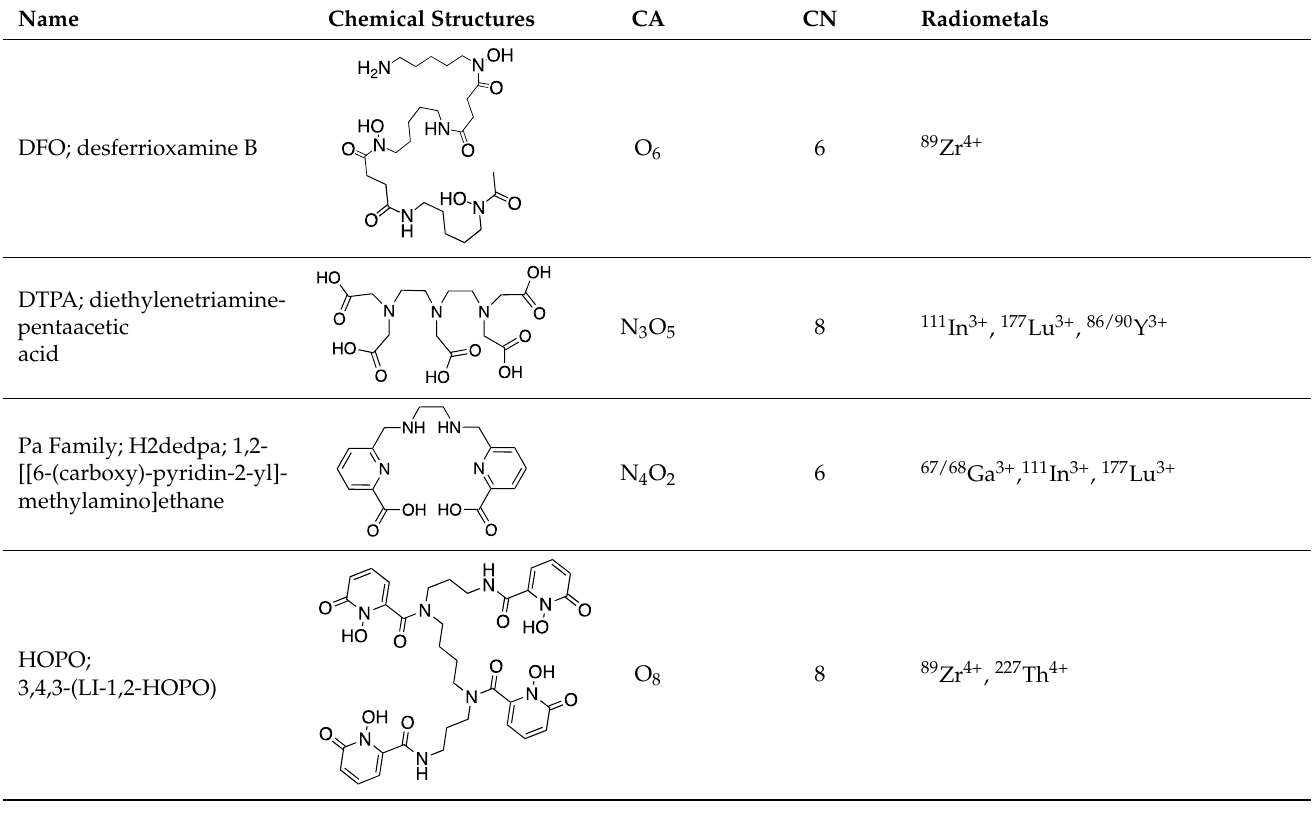
Table 1. Chelators (including their respective derivatives) and their most suitable radiometal counterparts commonly used in biomedical applications [29]. (CA: Coordinating Atoms; CN: Coordination Number).